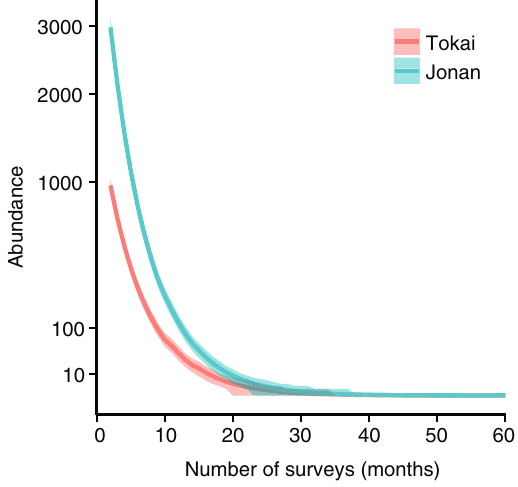
Figure 1. Changes in the estimated number of Argentine ants with the number of surveys. Dark-coloured curves indicate posterior means. Shading indicates the 95% credible intervals.